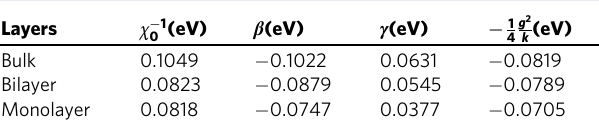
Table 2 Parameters that characterize the electronic and total energy of NdNiO 3 and NdNiO 3 /NdAlO 3 heterostructures consisting of a single or two layers of NdNiO 3 from ref. 4 .